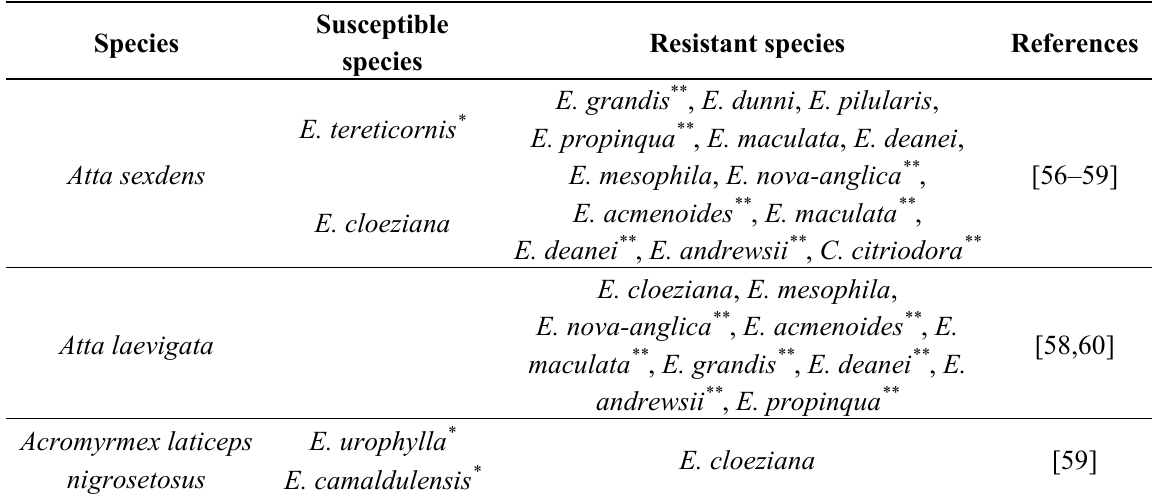
Table 1. Leaf-cutting ants’ susceptible and resistant Eucalyptus